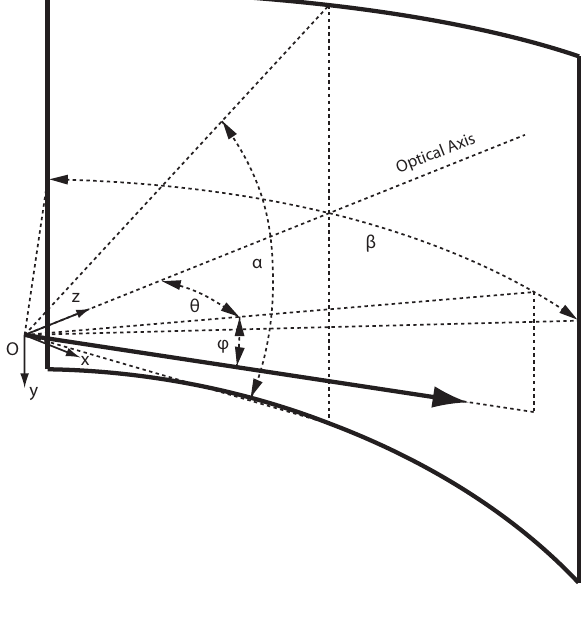
Figure 6. Parametrization of the virtual cylinder used to define the panoramic field of view for unwrapping of the raw images. The reference ( x, y, z ) indicates the orientation of the coordinate system attached to the